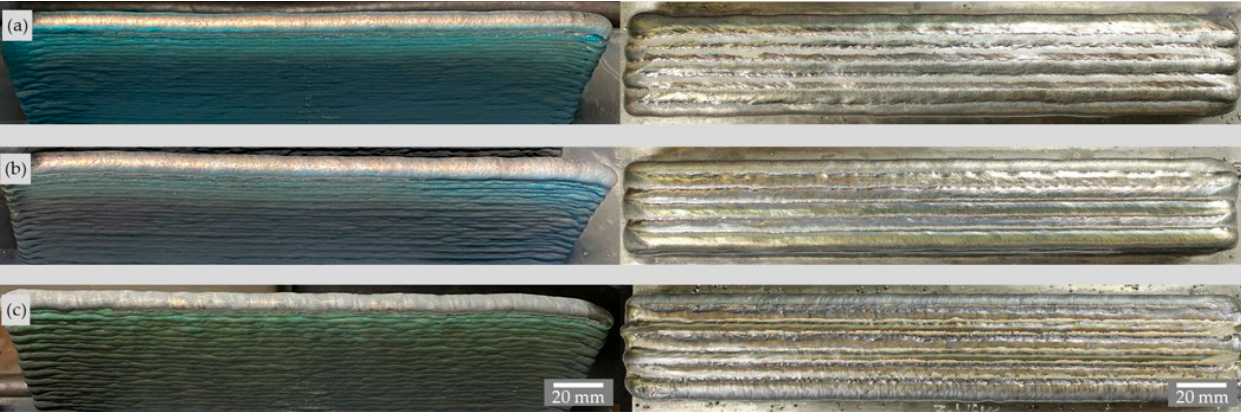
Figure 7. Side view of the unbrushed walls (left) and top views of the brushed blocks (right). ( a ) Z-ArHeHC; ( b ) R1-ArHeH; ( c ) Z-ArHeNC (welding parameters in Table 4).